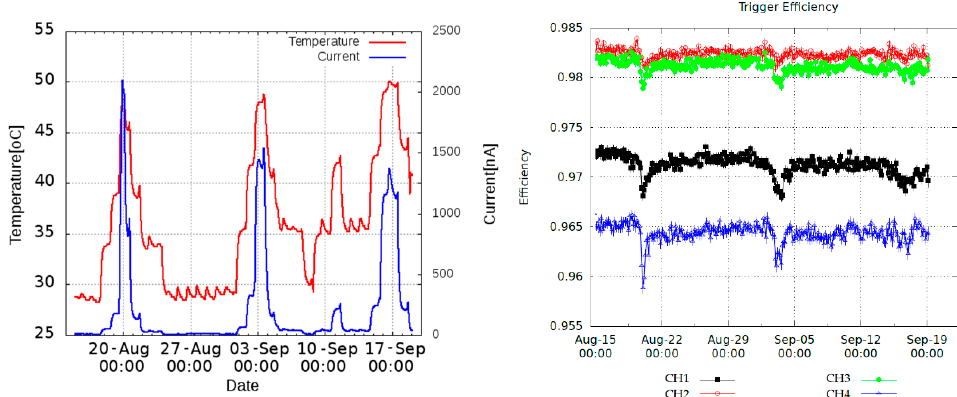
Figure 7. The temperature and the current values are also plotted during the 36 days of measurement period ( left ). Note the dark current peaks during elevated temperatures. The trigger efficiency of the chambers was sufficiently high in the whole period ( right ).